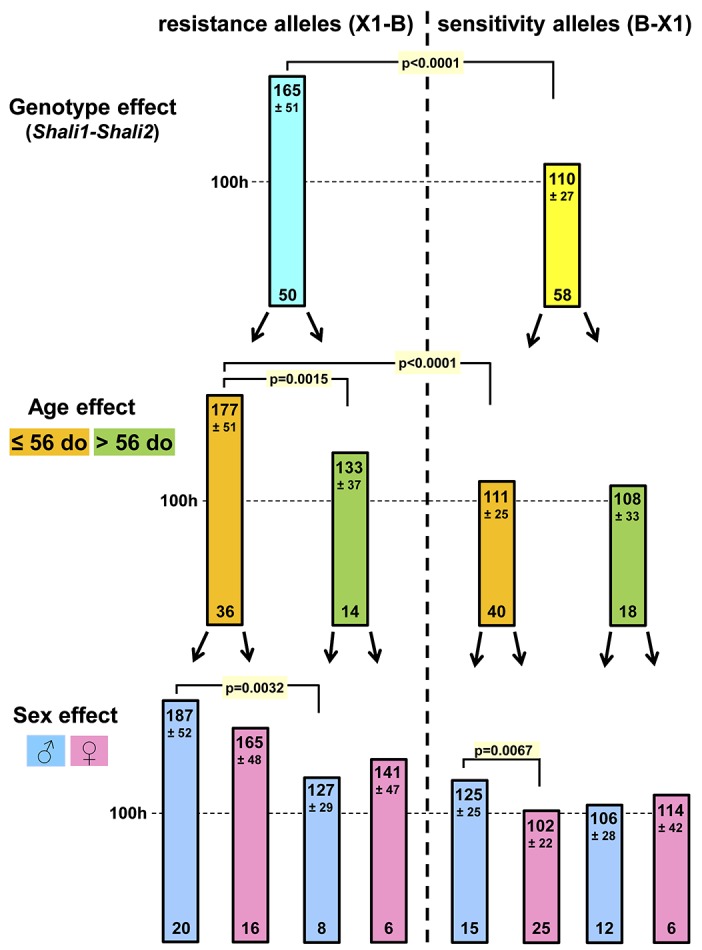
Age and sex-specific survival differences of F2 mice carrying reciprocal alleles for Shali1 and Shali2.The (X1xB) F2 dataset (n = 840) was sorted based on resistance (X1-B) or sensitivity (B-X1) alleles (i.e., genotype effect) at both of the peak markers representing Shali1 (D1Mit303) and Shali2 (D4Mit308). Mice with the most resistant (X1-B; n = 50) and most sensitive (B-X1; n = 58) allelic combinations at these two loci were then segregated by age (using a 56 d.o. threshold for younger vs. older mice) and sex, and compared at each stage. Numbers near the top of each bar represent mean survival times (hours) and SDs rounded to the nearest hour, and those at the bottom of bars are numbers of mice with the corresponding variables (genotype/age/sex). Significant differences are as indicated, using the t-test for group comparisons and Bonferroni corrections for multiple testing.